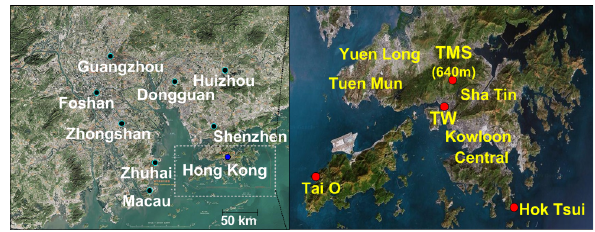
Figure 1. Tai Mo Shan (TMS) and Tsuen Wan (TW) sampling sites and the surrounding environments in Hong